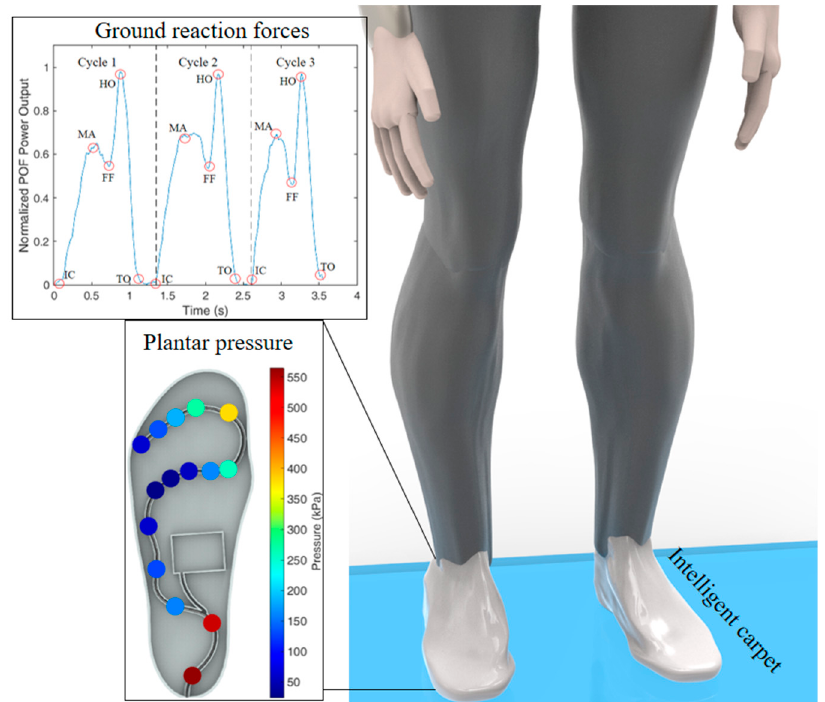
Figure 9. Plantar pressure instrumentation systems using POF sensors.